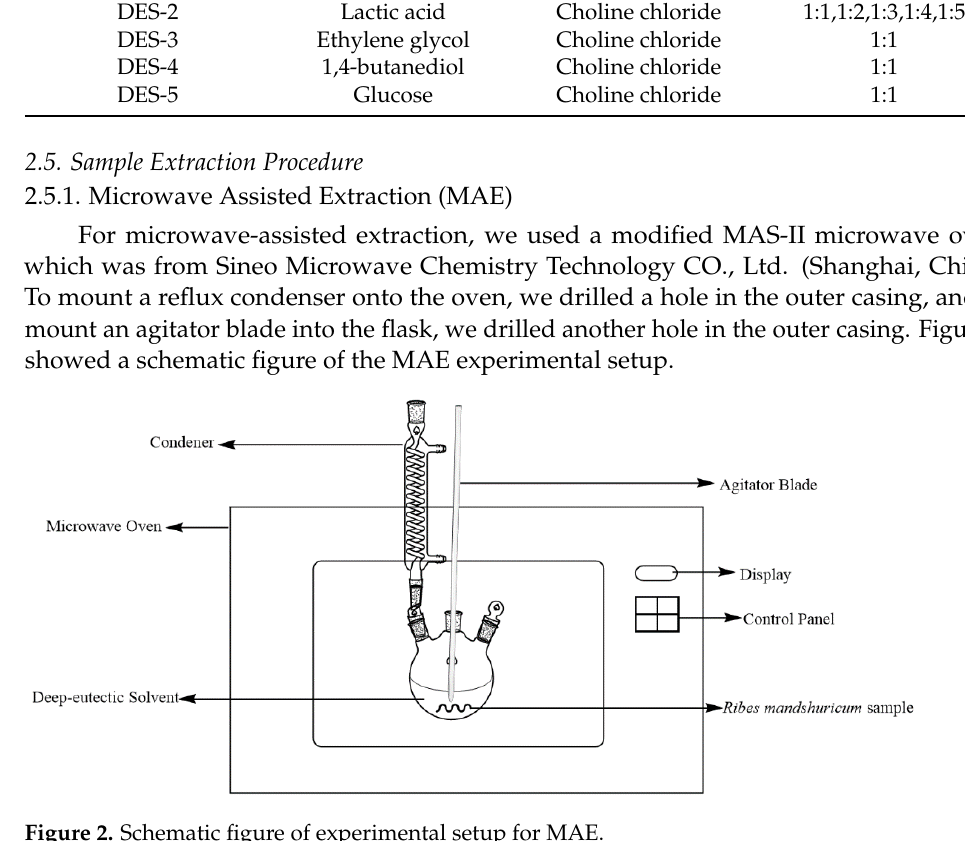
Figure 2. Schematic figure of experimental setup for MAE.